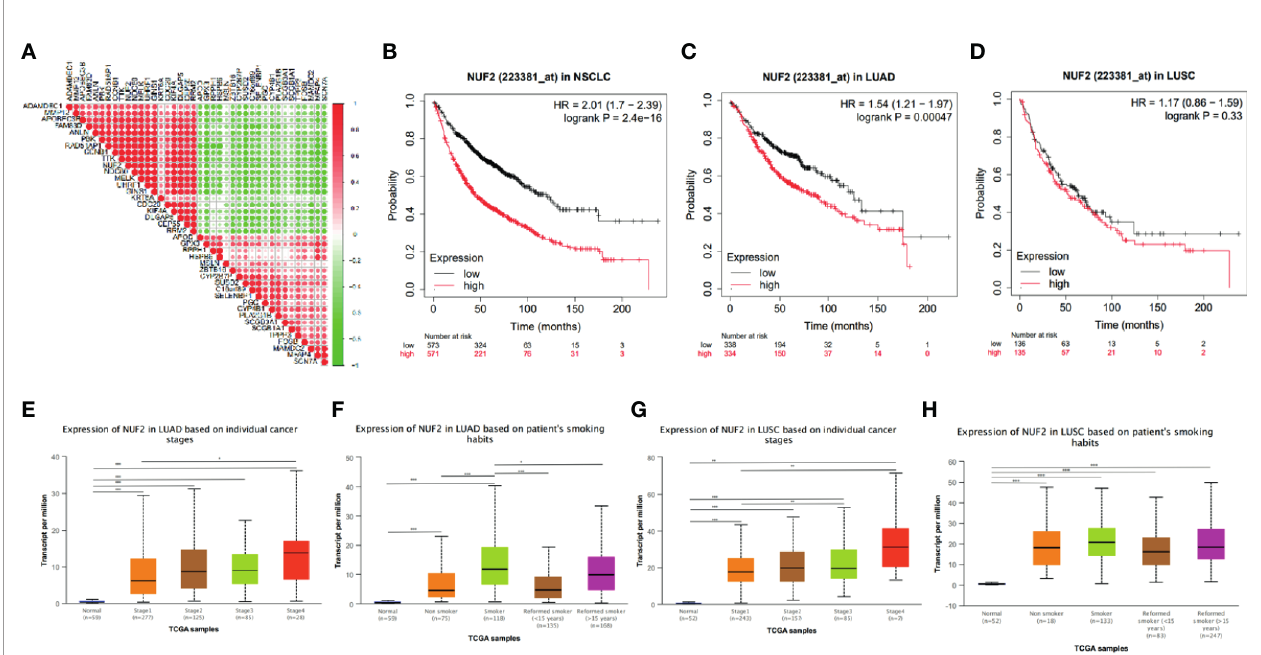
FIGURE 3 | (A) The correlation analysis of TOP20 differentially upregulated and downregulated expressed genes. (B – D) Kaplan-Meier survival curve comparing the OS time for different NUF2 expression subgroups in NSCLC and the subtypes (LUAD and LUSC) of NSCLC. (E – H) The association of NUF2 expression with clincopathological factors. Expression of NUF2 in NSCLC with different stages and smoking habits based on TCGA sample via UALCAN. *p < 0.05, **p < 0.01, ***p <